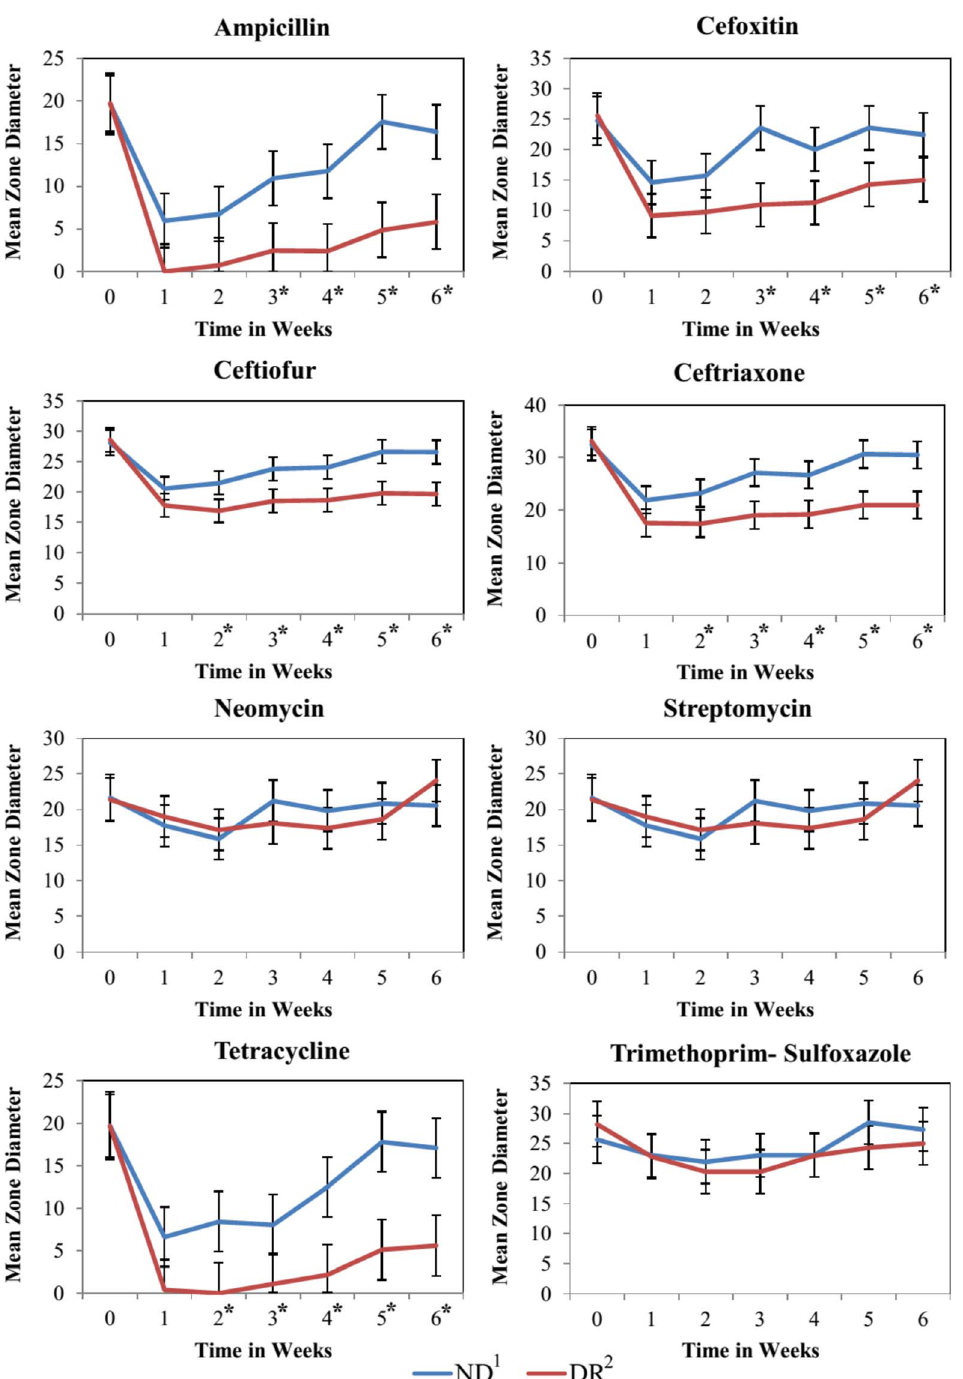
Fig. 4. The effect of milk feeding treatment on the least square means of the zone diameter of E. coli at the calf level over time in weeks. Error bars represent 95% confidence interval of the least square mean. 1. Calves fed raw milk without the addition of sub-MICs of antimicrobial drugs. 2. Calves fed raw milk with the addition of sub-MICs of ceftiofur, penicillin, ampicillin, and oxytetracycline from birth to 6 weeks of age. *Sampling weeks where the mean zone diameter was significantly different between NR and DR.